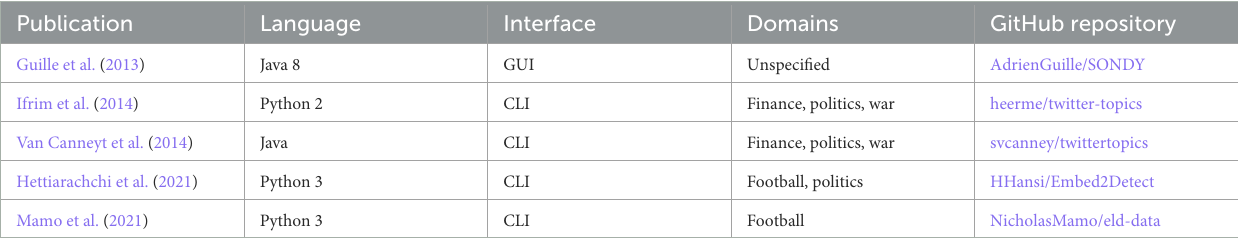
TABLE 9 TDT literature has very few open-source algorithms.